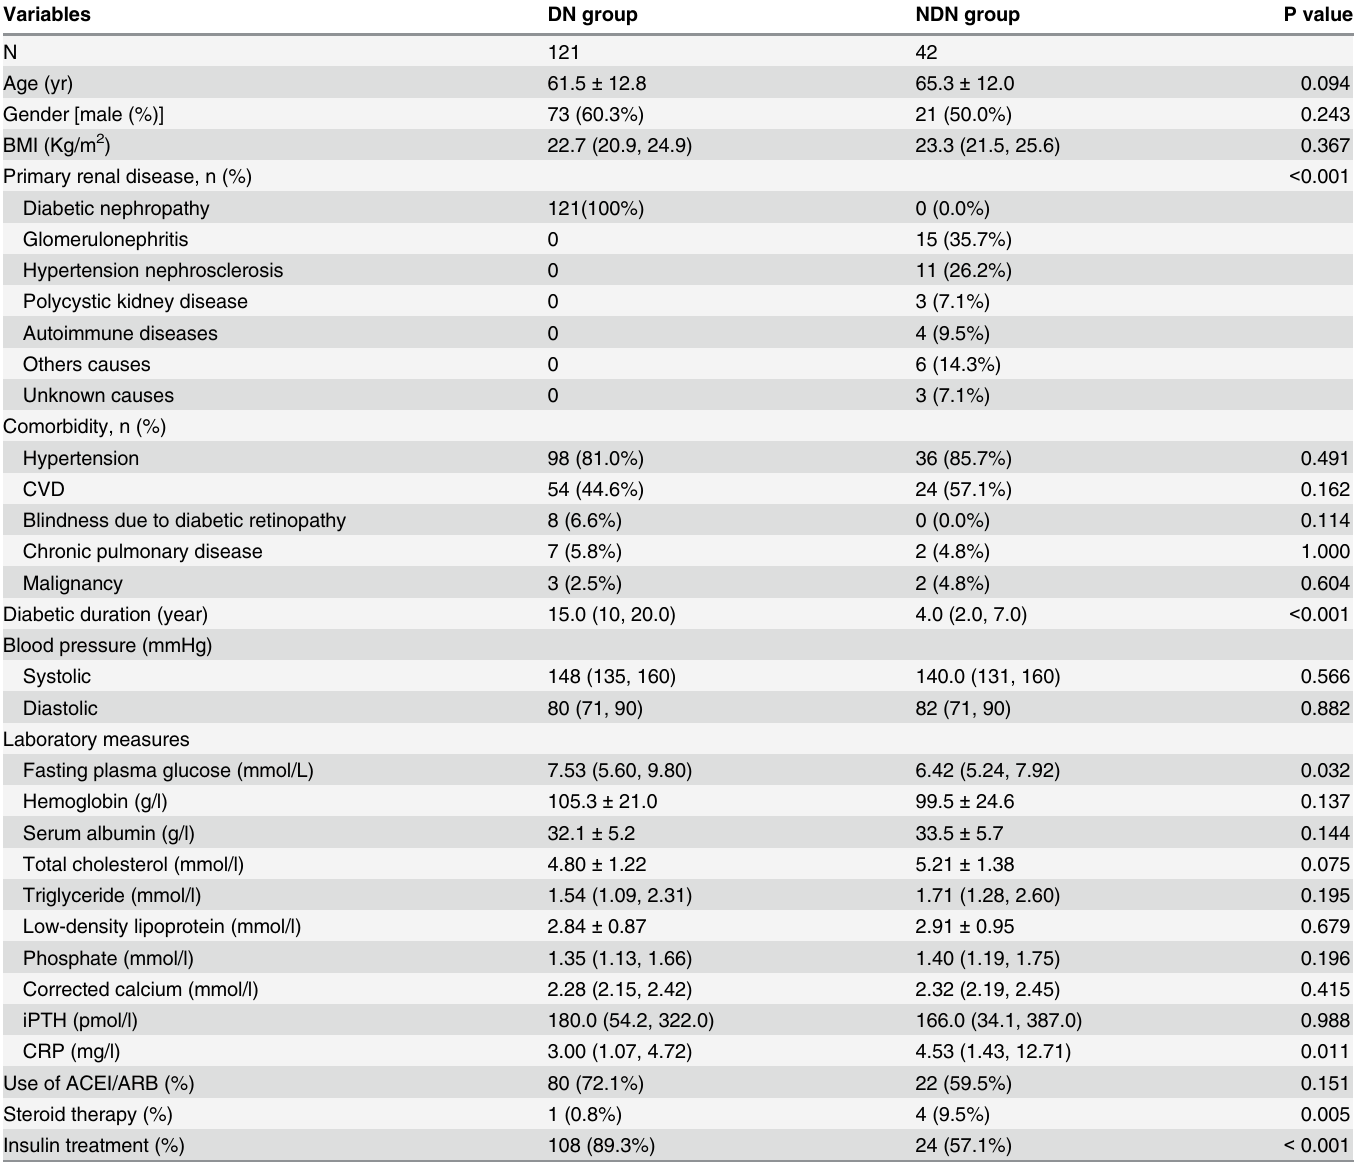
Table 1. Demographic and baseline characteristics of the study